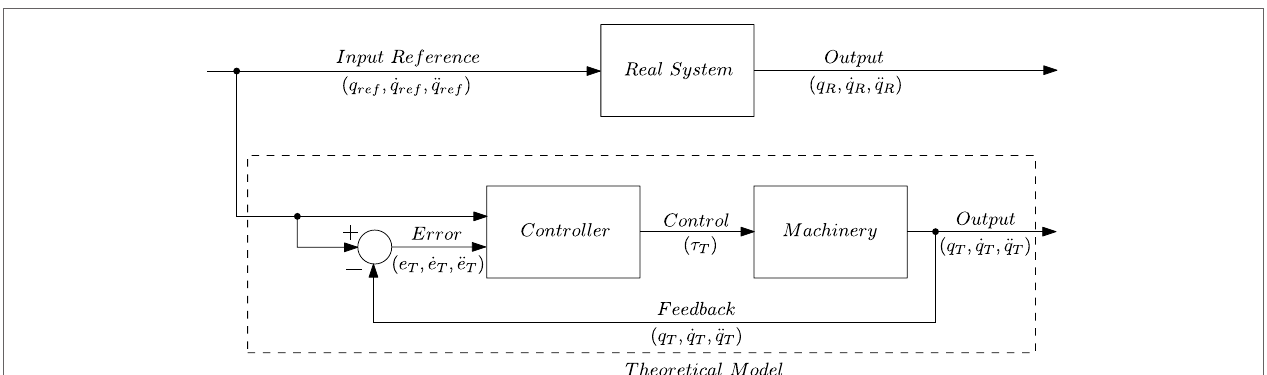
FIGURE 2 | Real system and its theoretical model to be